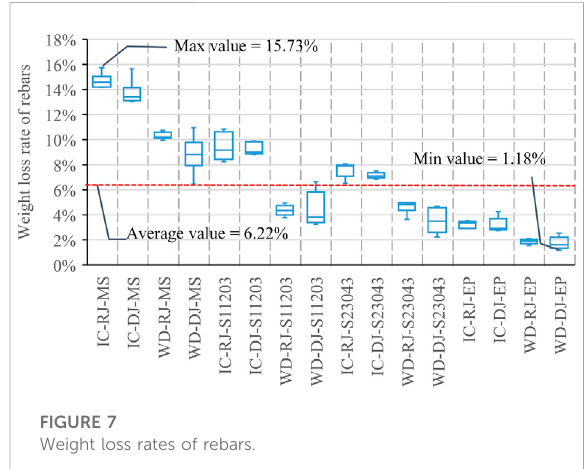
FIGURE 7 Weight loss rates of rebars.